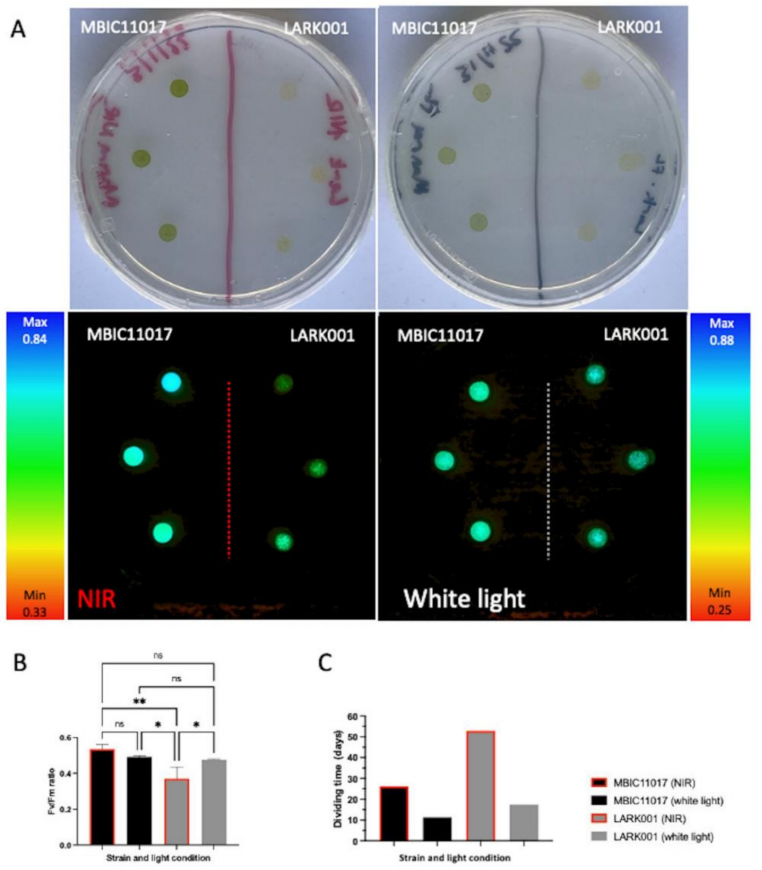
Figure 6. Fluorimetry measurement by PAM. ( A ) Clockwise from top left: Cultures grown for 3 weeks in NIR after 50,000/25 µ L cells of each strain were added to the surface of the agar plate in triplicate. Cultures grown for 3 weeks in white light after 50,000/25 µ L cells of each strain were added to the surface of the agar plate in triplicate. PAM imaging of the white light incubated cultures. PAM imaging of the NIR incubated cultures. ( B ) Fv/Fm measurements for the cultures and graph showing pairwise comparison * p < 0.05, ** p < 0.01. ns: not significant. ( C ) Doubling time of each strain in either white light or NIR